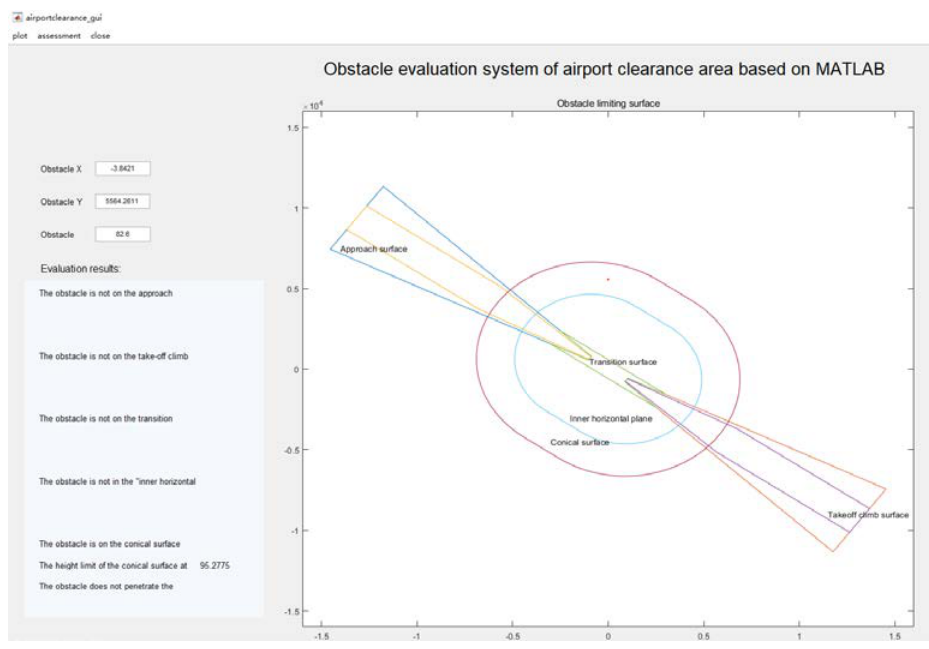
Fig. 3. Obstacle evaluation of airport clearance area based on MATLAB.